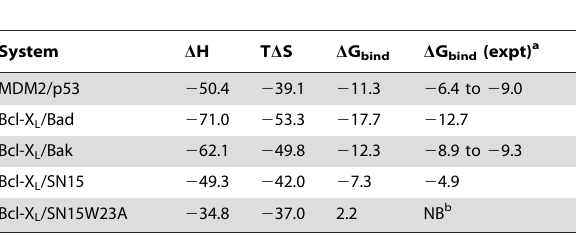
Table 2. Bind free energy (kcal/mol) and components for different protein-peptide complexes.